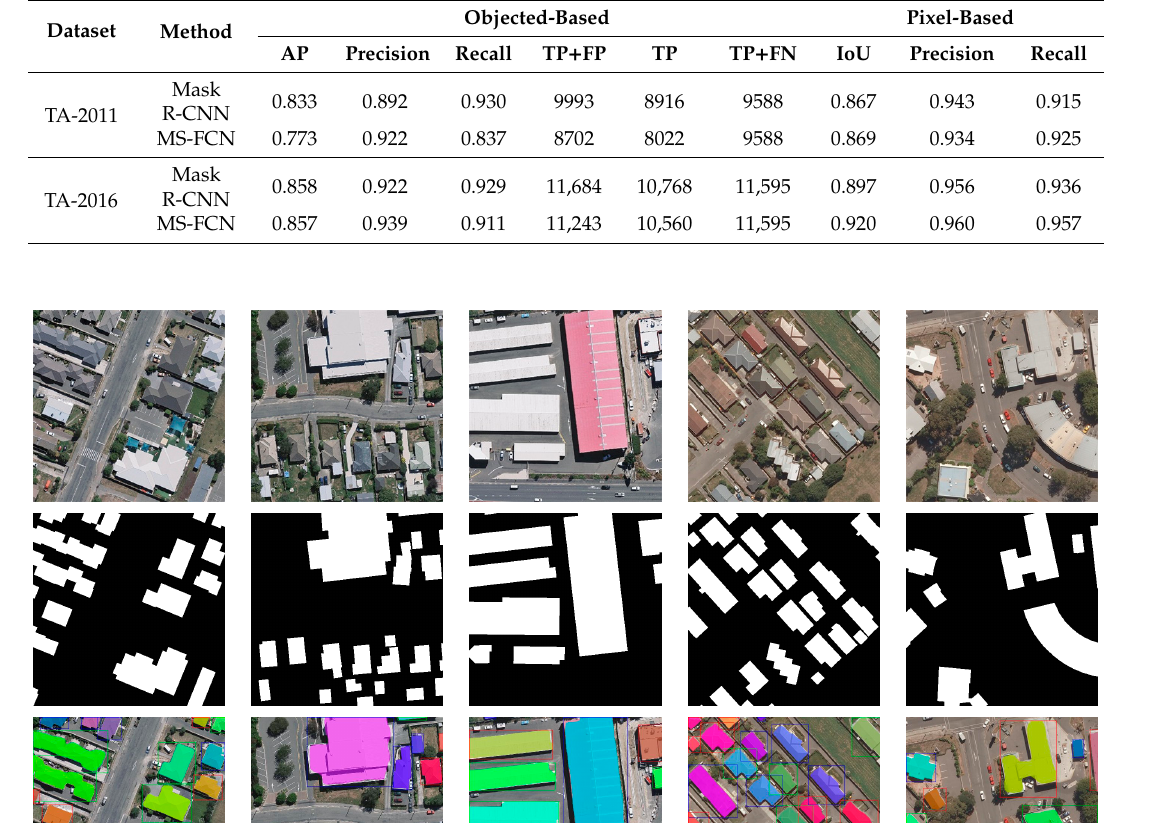
Table 2. Building extraction accuracy of the Mask R-CNN and MS-FCN at the object and pixel levels in the test area.